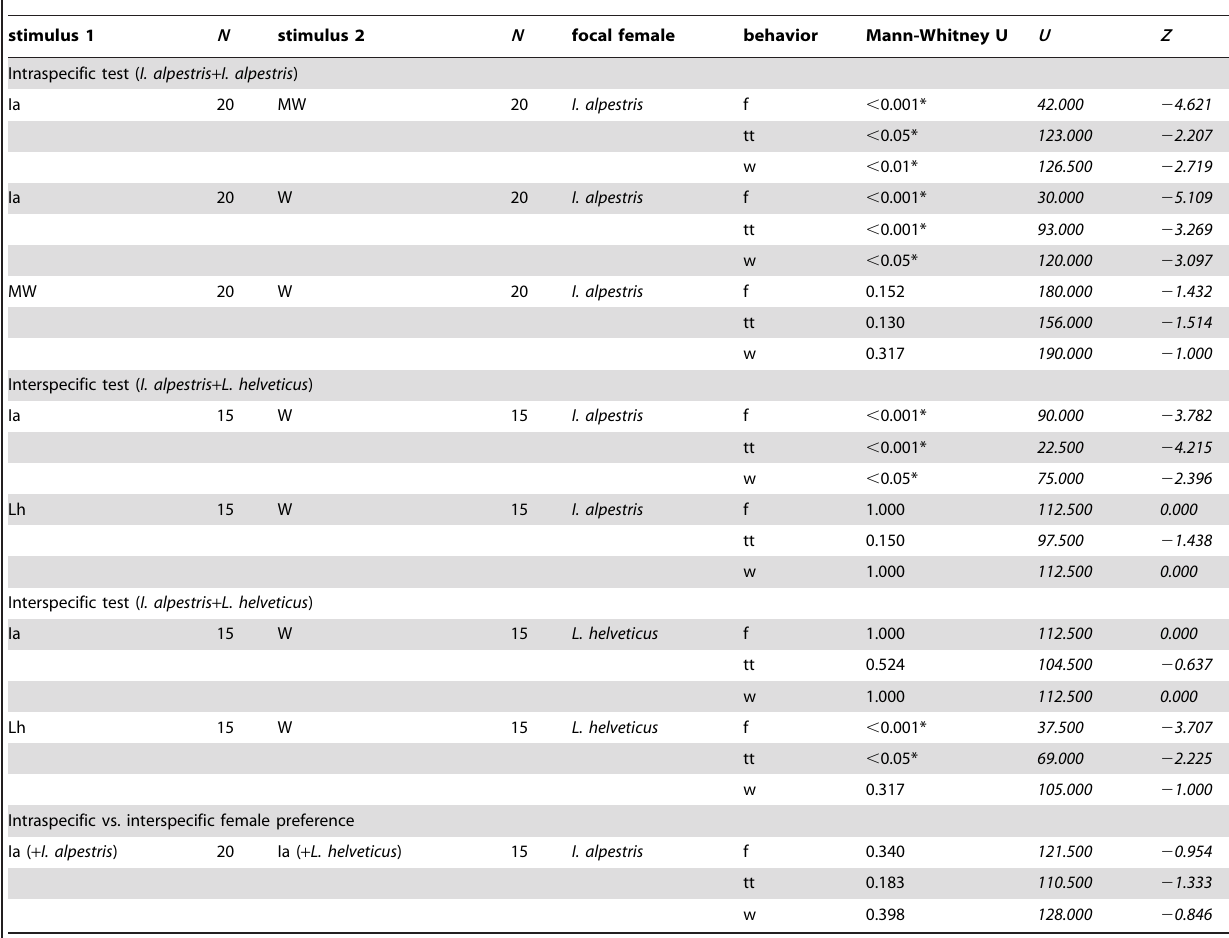
Table 1. Results of the statistical